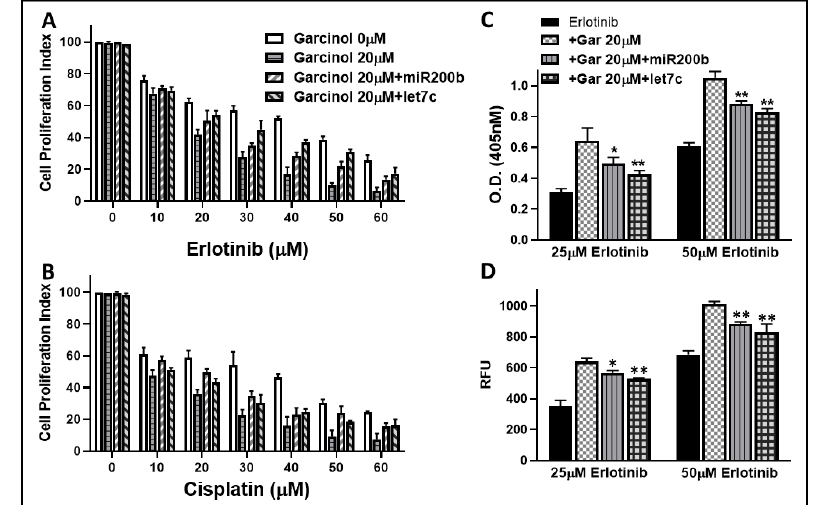
Figure 6. Mechanistic role of miRNAs in drug sensitization. Effect of anti-miRNAs was evaluated on garcinol-induced sensitization of A549M cells to erlotinib ( A ) and cisplatin ( B ), through MTT assay. Treatment with drugs in the absence (garcinol 0 μ M) or presence of 20 μ M garcinol was for 72 h, after transfections with non-specific or specific anti-miRNAs. Effect of anti-miRNAs was also evaluated on potentiation of apoptosis induction as assayed by Histone/DNA ELISA ( C ) and homogeneous caspase-3/7 assay ( D ). * p < 0.05 and ** p < 0.01, compared to garcinol 20 μ M.